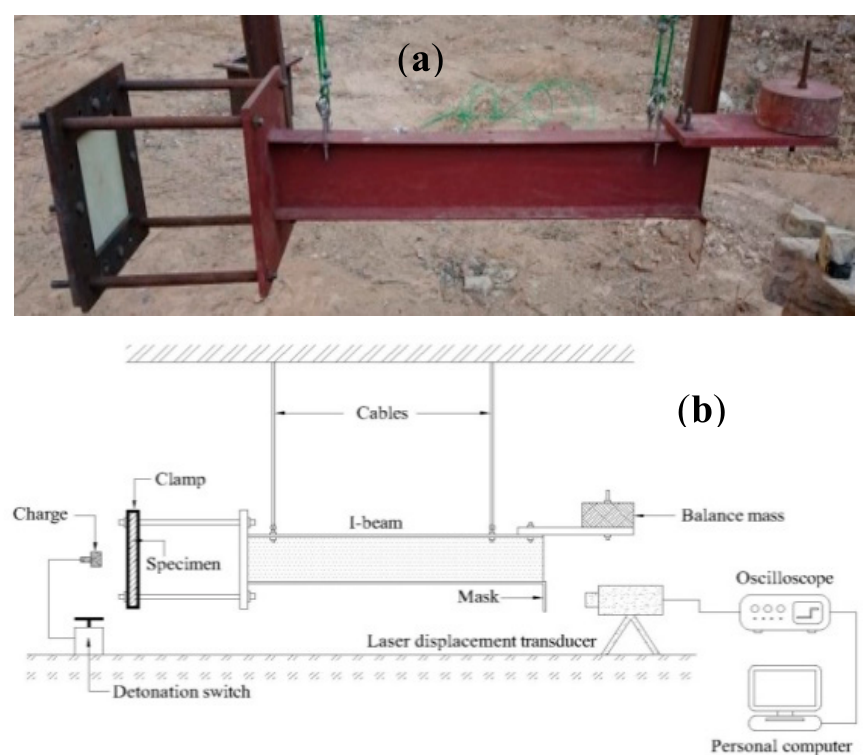
Figure 3. The blast test set up ( a ) four-cable pendulum blast system. ( b ) Schematic of the four-cable pendulum blast set